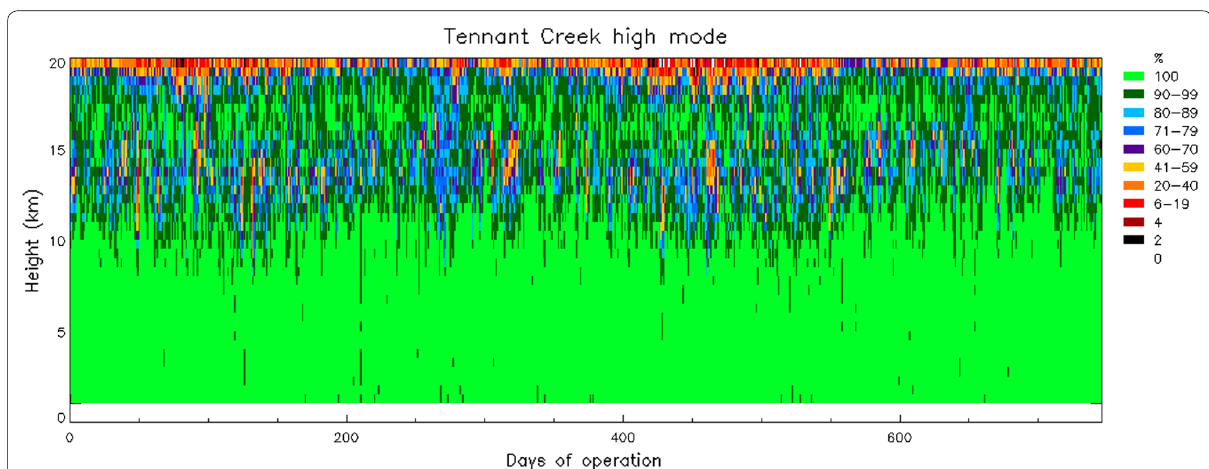
Fig. 6 Tennant Creek high - mode daily 90% acceptance summary plot. The x axis shows days beginning from December 13,